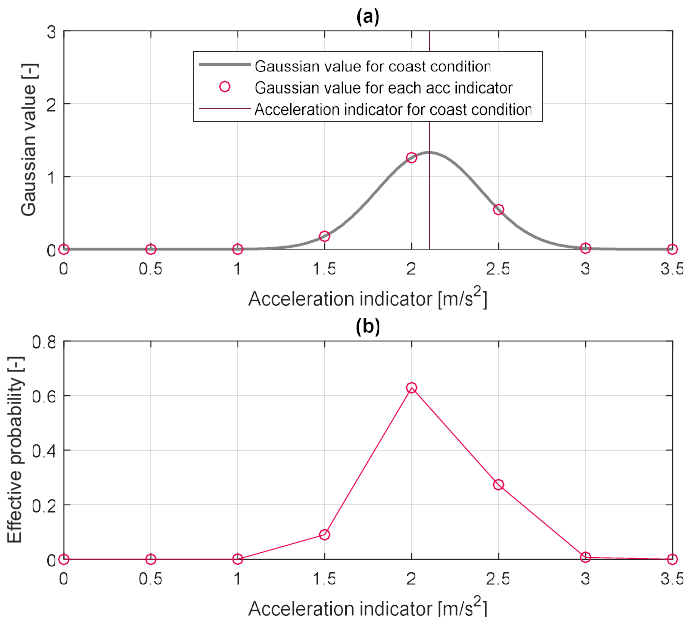
Figure 8. Gaussian value and effective likelihood according to acceleration indicator value. ( a ) Gaussian value, ( b ) Effective likelihood.